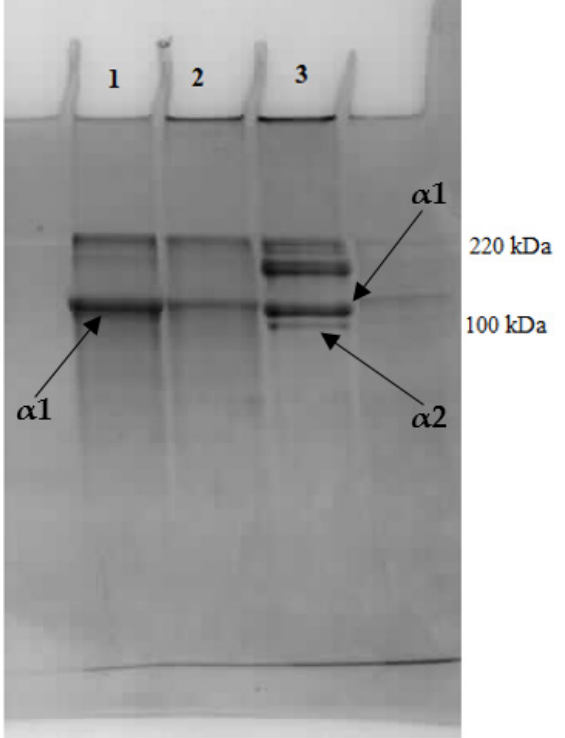
Figure 6. SDS–polyacrylamide gel electrophoresis of atelocollagen fibers isolated from chicken keel cartilage after preliminary proteoglycan extraction with (1) MgCl 2 solution; (2) NaCl solution; (3) collagen type I (Sigma Aldrich).